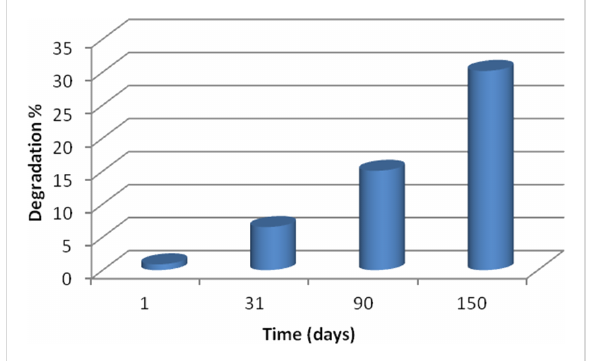
Figure 2: In vitro degradation of CA scaffolds as a function of the